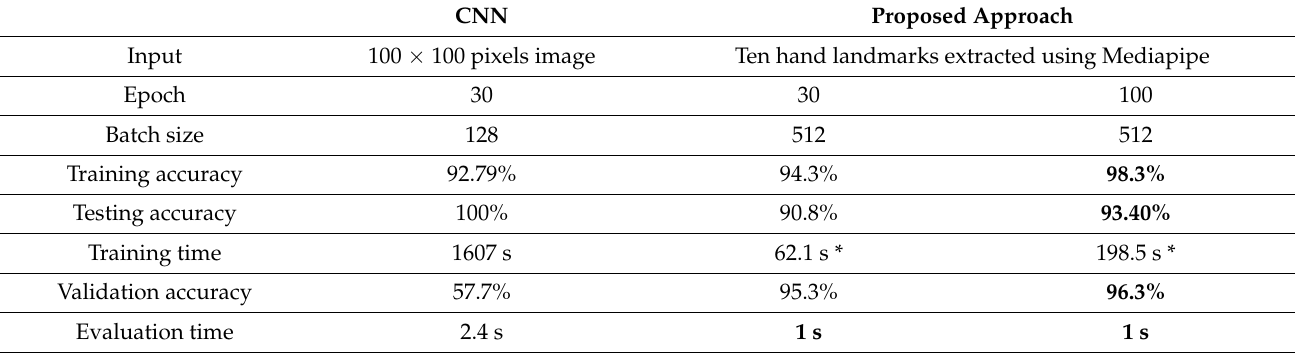
Table 4. Comparison between CNN and our proposed